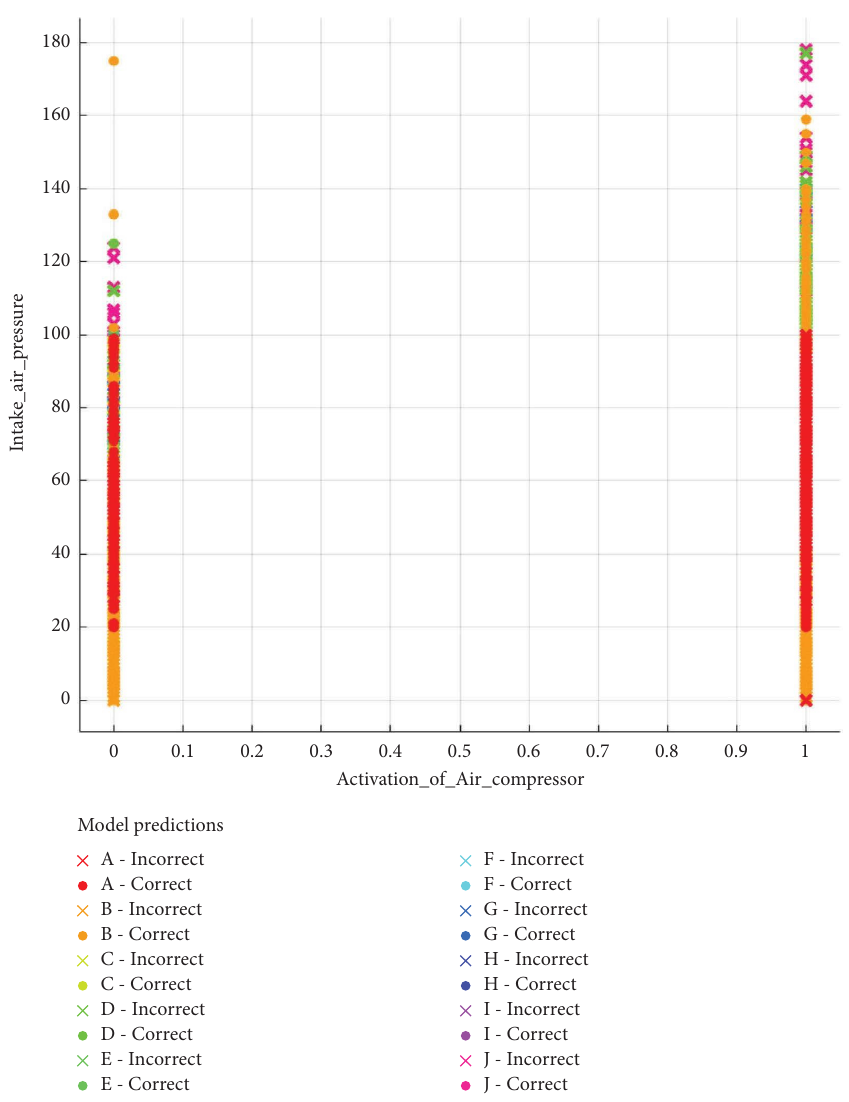
Figure 3: Model prediction with features activation of air compressor vs. intake air